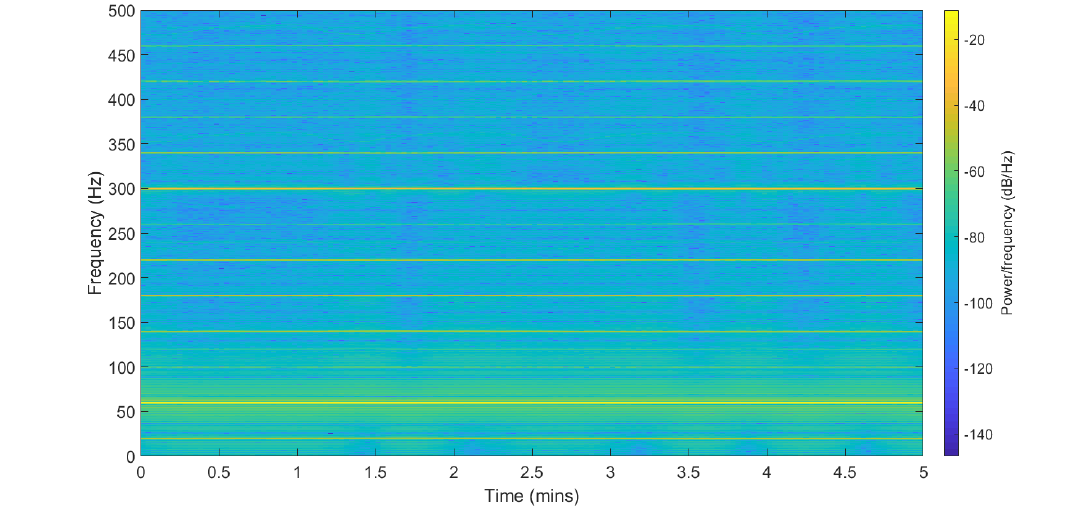
Figure 1. Spectrogram of power